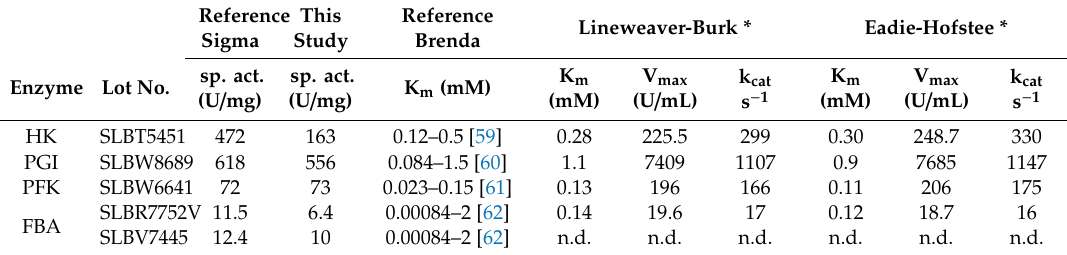
Table 3. Comparison of ANN predicted flux (J ANN in µM/s), simulated flux (J Copasi in µM/s) and experimentally assessed flux (J Exp in µM/s). The four enzymes PGI, PFK, FBA and TPI were used at the indicated concentrations for the experimental assessment of the flux with mean deviation (M.D) of triplicates.